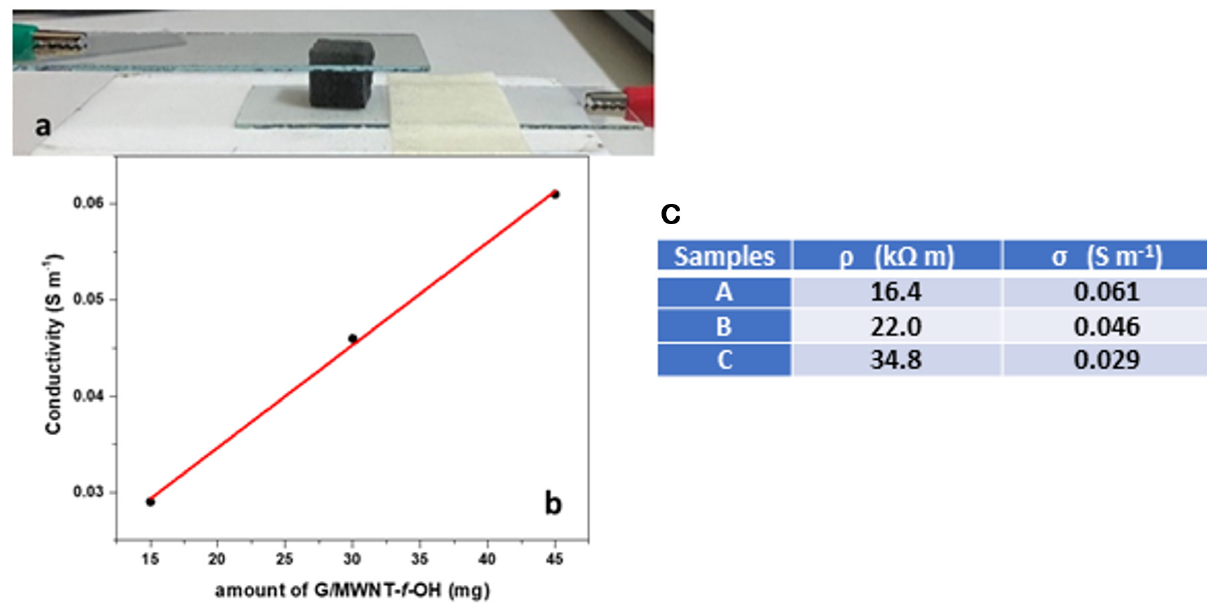
Figure 1. ( a ) A piece of MS impregnated with the composite hybrid G/MWNT- f -OH mixed with cellulose between ITO covered glass slides; ( b ) the conductivity of the MS samples vs. the amount of the conductive component, G/MWNT- f -OH; ( c ) the measured values of resistivity and conductivity of samples A–C.